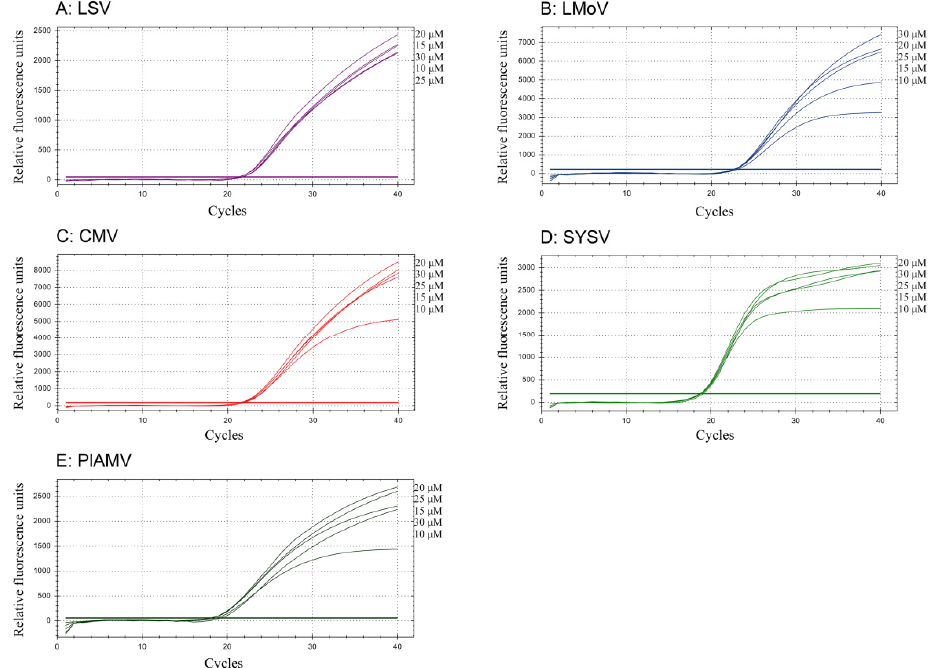
Figure 1. Optimization of the concentration of primers and probes for multiplex TaqMan real-time PCR assay to detect LSV ( A ), LMoV ( B ), CMV ( C ), SYSV ( D ), and PlAMV ( E ).